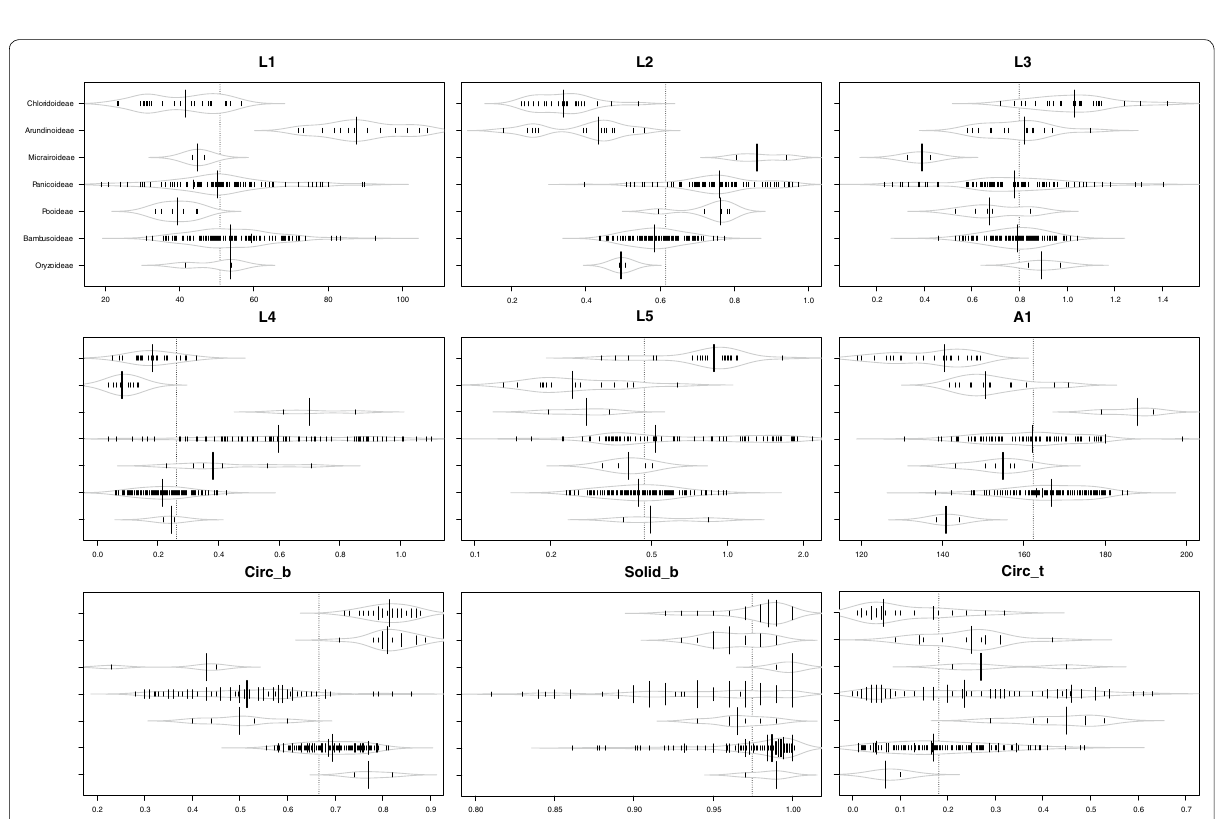
Fig. 3 Bean plots of the nine shape parameters, showing the variation of bulliform phytoliths among the Poaceae subfamilies. Long lines show the medians; short lines represent individual data points; areas represent the estimated density of the data. Subfamilies are arranged in the same order in all